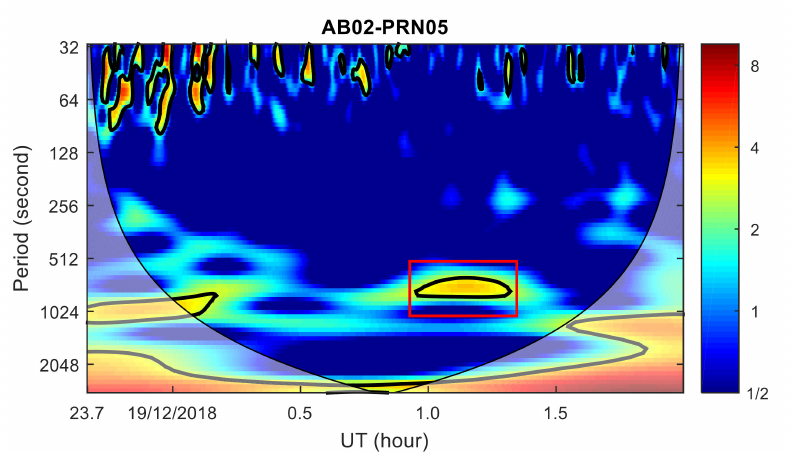
Figure 9. Wavelet transform power spectrum of TEC time series at AB02 station. Shadow region regions on either end indicate the “cone of influence”, where edge e ff ects become important.